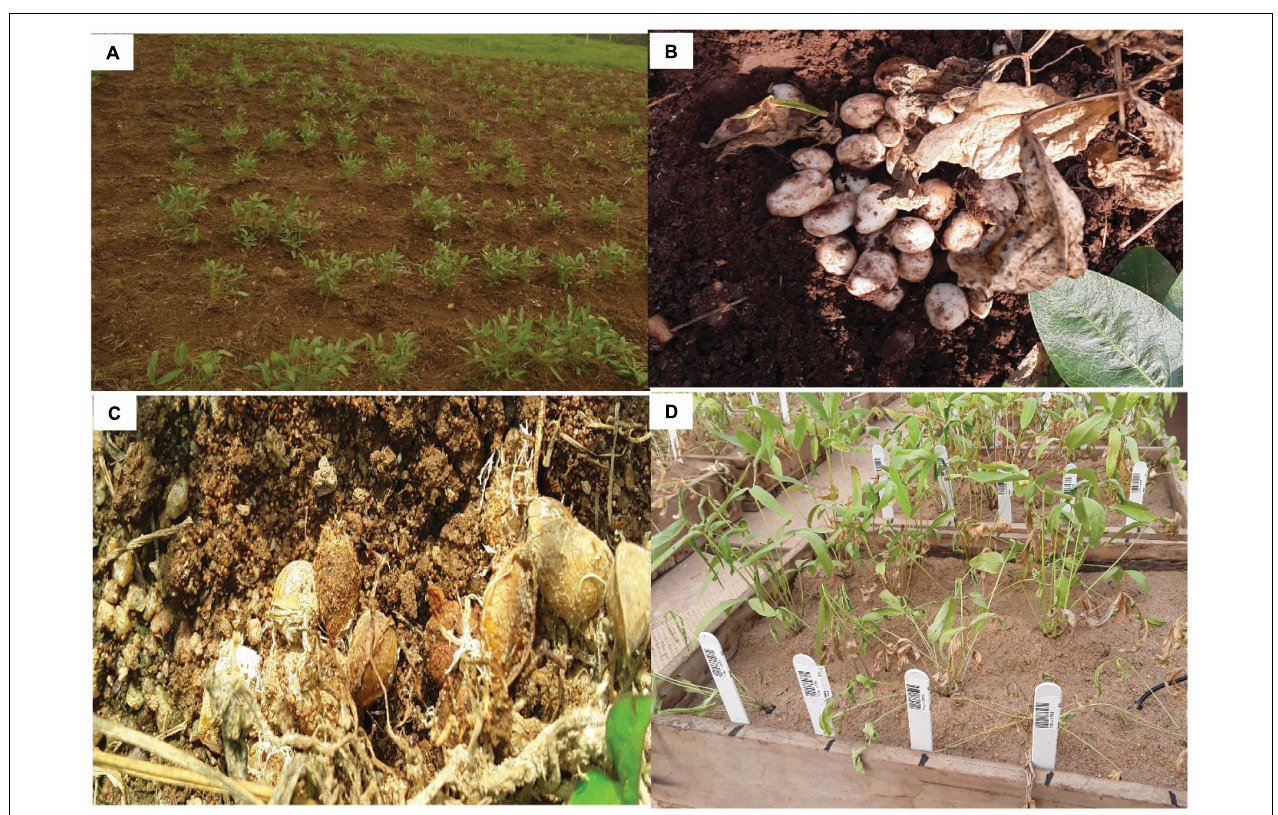
FIGURE 3 | (A) Bambara groundnut (BGN) on the field; (B) healthy matured BGN pods during harvest; (C) infected BGN pods; (D) drought stressed BGN